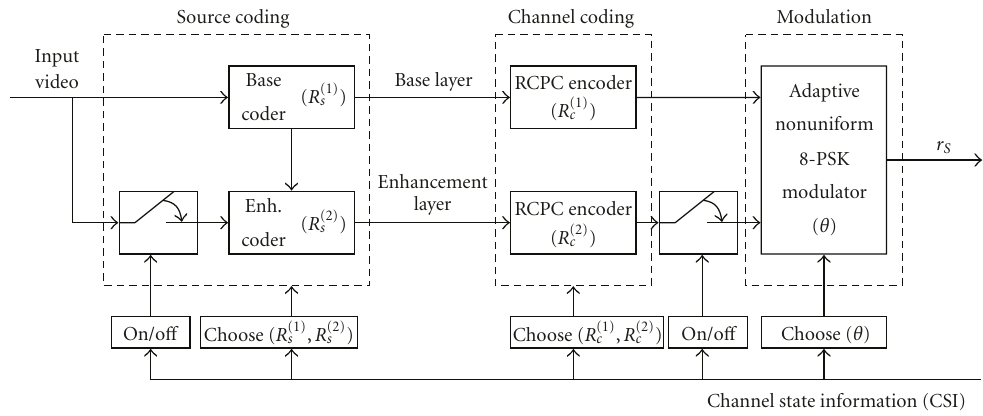
Figure 6: Adaptive multiresolution modulation and coding scheme for wireless delivery of digital